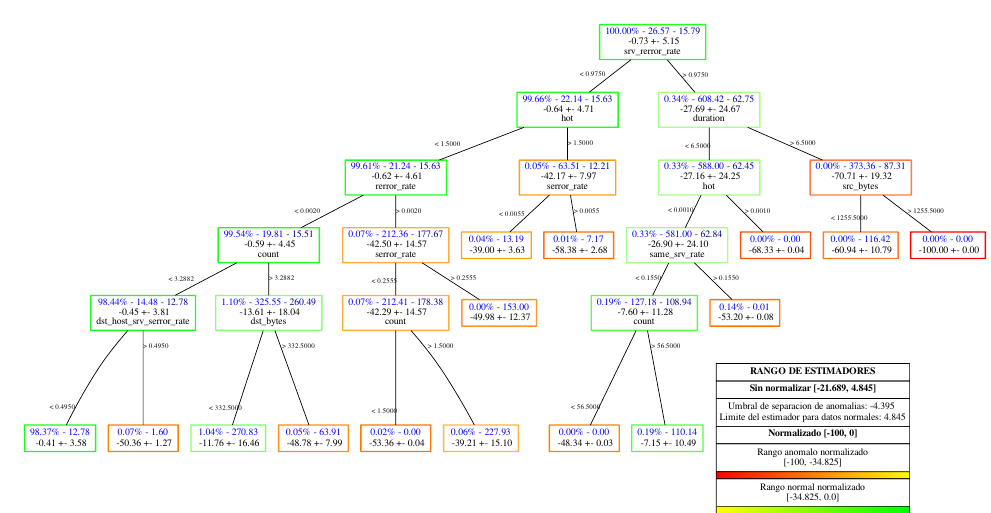
Figure 1. Explanatory tree after pruning ( λ = 10 − 3 ) using the KDDCup99-SMTP dataset. Named sequentially, reading from left to right, each node shows: the proportion of elements that it represents regarding the full dataset (shown in blue), overall variance (shown in blue), the weighted variance w.r.t children nodes (shown in dark blue) and mean and standard deviation for the subset of estimators. Further experimental results are given through supplementary materials